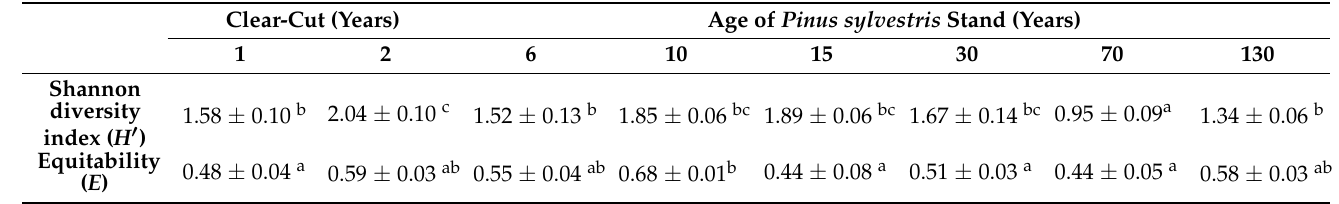
Table 3. Shannon species diversity index ( H (cid:48) ), and equitability ( E ) of ground vegetation species at different Pinus sylvestris sites, including 1–2-year-old clear-cuts and 6–130 years old stands. Different letters a, b, and c indicate significant differences among sites ( p < 0.05).